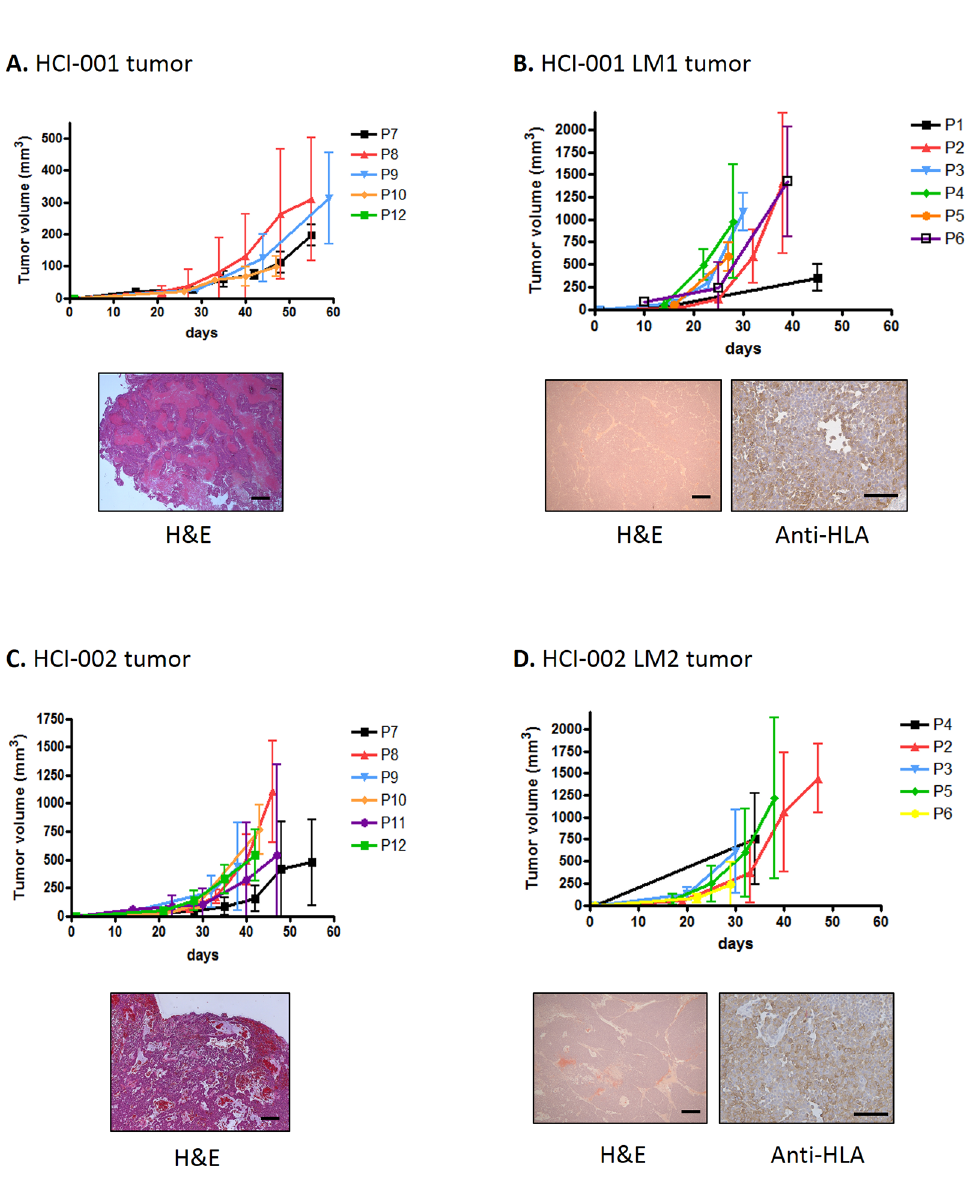
Fig 2. Acceleration of tumor growth of the variants derived from a metastasis. Graph showing the tumor growth rate of consecutive passages of two different tumors and their variants derived from lung metastases and representative slides stained for H&E: A. HCI-001; B. HCI-001 LM1; C. HCI-002; and D. HCI-002 LM2. Tumors did not show an increase in their growth rate with successive passages. The variants derived from lung metastases have an accelerated growth when implanted orthotopically as primary tumors in the mfp compared to the parental tumors. Scale bars, 150 μ m.